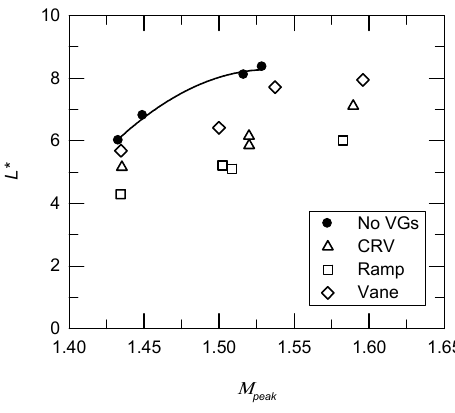
Figure 15. Normalized separation length versus peak Mach number. THM was used to determine f s with/without MVGs, as shown in Figure 16. For the baseline case, the value of f s (640–1320 Hz) decreases as M peak increases [4]. There is a significant reduction in the value of f s when MVGs are installed, particularly for the CRV type. This is similar to the variation in ( σ p / P w ) max . The data also shows that the decrease depends on M rather than η . The respective values for the CRV type for f s are 535 Hz and 70 Hz for M = 0.83 and 0.89.